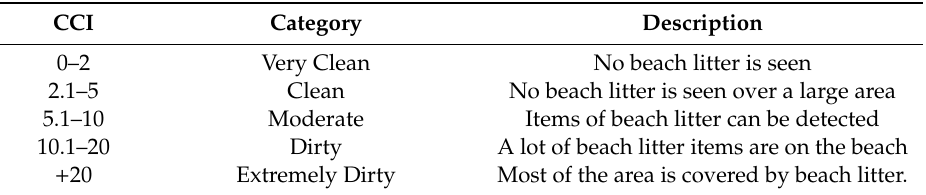
Table 3. Clean Coast Index (CCI)